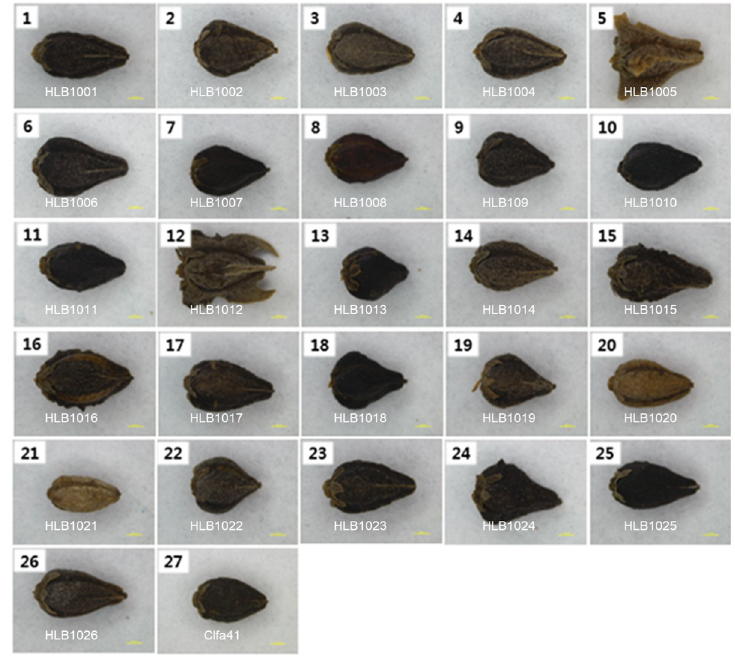
Fig 1. The seed morphology of 26 re-sequenced tartary buckwheat accessions and Clfa41.